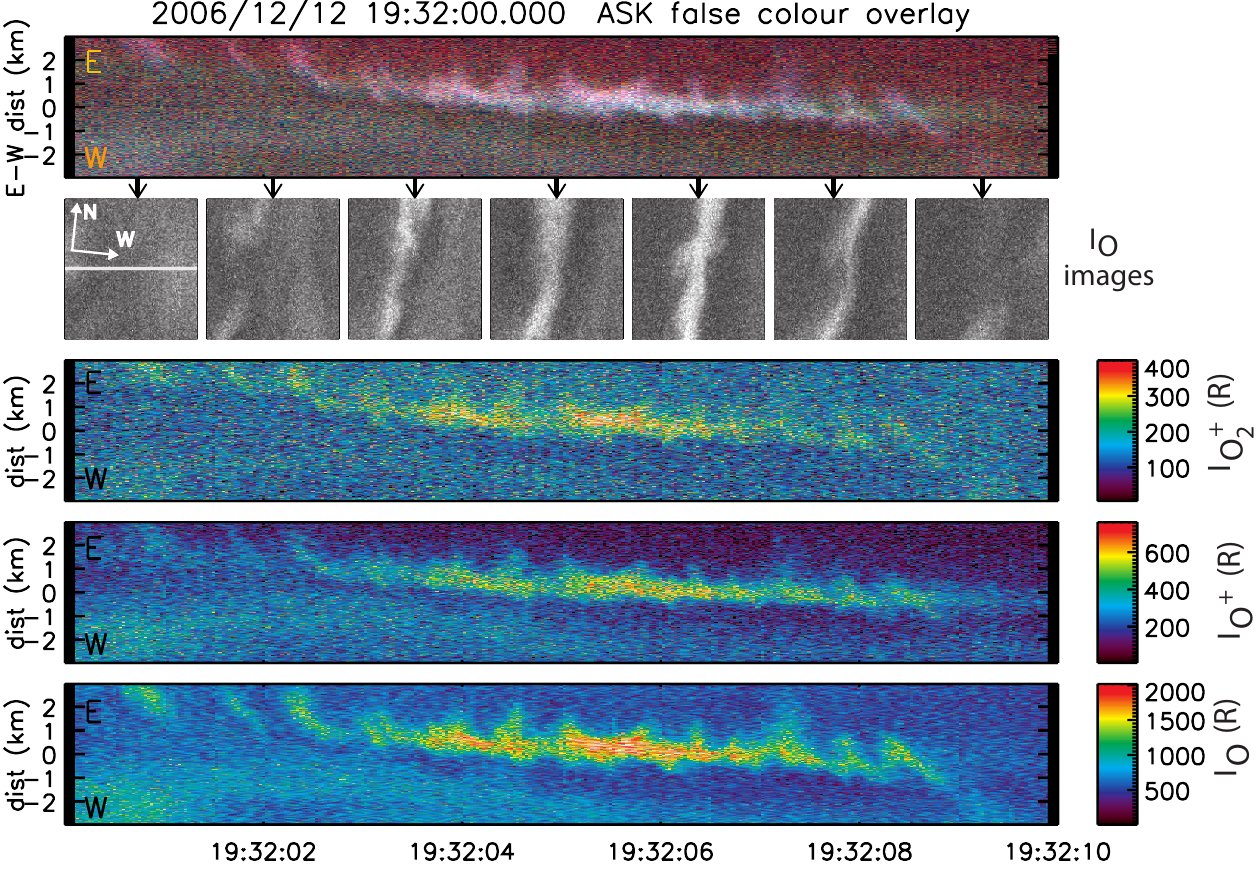
), ASK2 (I O + ) and O + 2 ), ASK2 (I ) and ASK3 O + O + 2